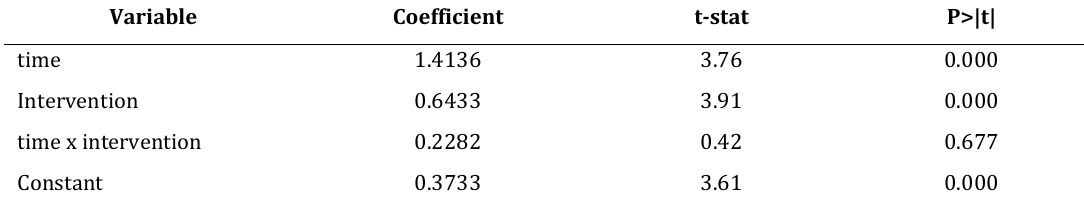
Table 8: The impact of EU entrance in the EU in terms of FDI compared to Norway and Iceland Variable Coefficient t-stat P>|t| time 1.4136